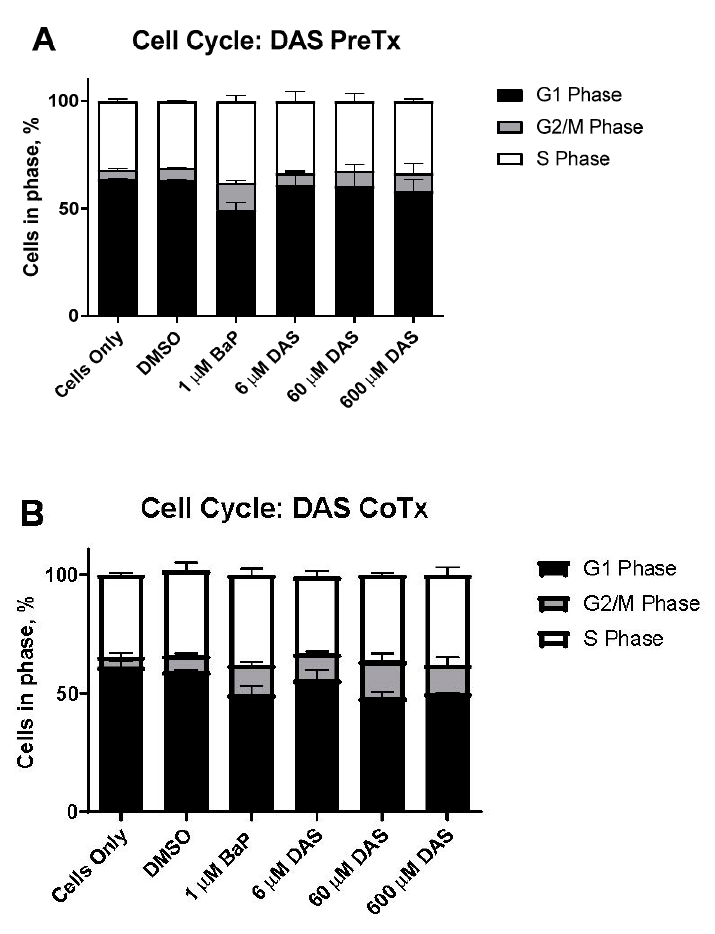
Figure 2. DAS inhibits BaP-induced G2/M cell cycle transition. The results of cell cycle analysis of MCF-10A were either pretreated with DAS (6, 60, and 600 µ M) followed by treatment with 1 µ M BaP for 24 h ( A ) or co-treated with DAS and BaP for 24 h ( B ). The cells were fixed in ethanol and analyzed by propidium iodide staining for flow cytometry. The values represent the average percent of cells in each phase, G1, G2/M, and S, for N = 3, ±SEM.